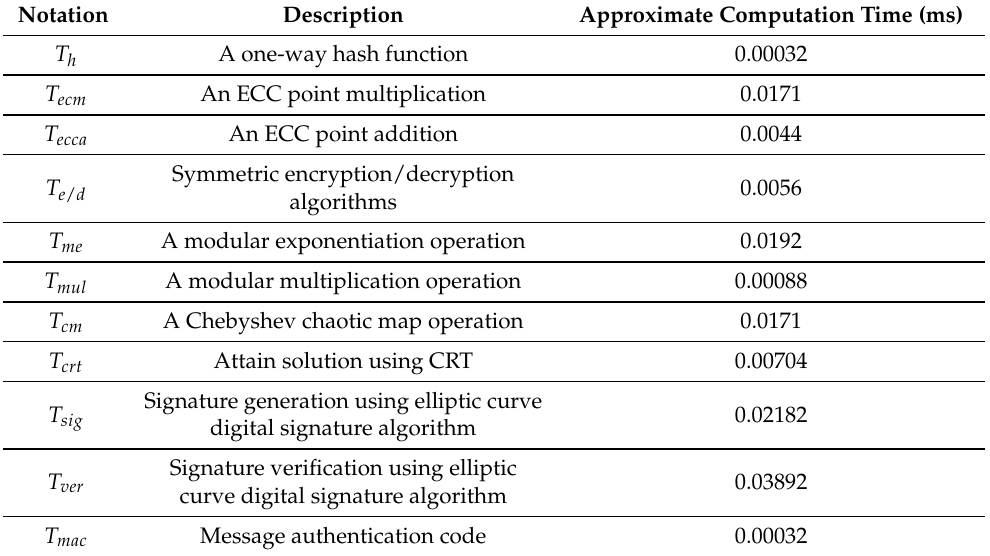
Figure 5. Approximate Time Required for Various Operations. Table 1. Time for Various Cryptographic